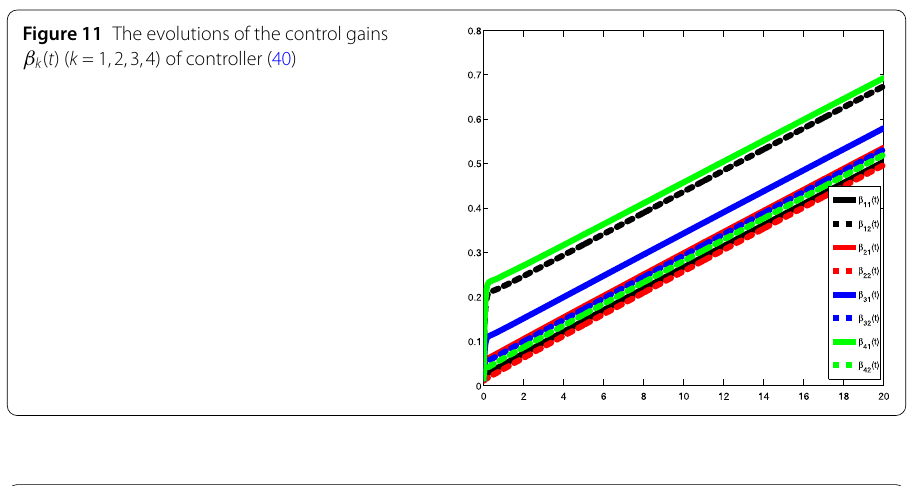
Figure 12 The evolutions of the control gains ξ k ( t ) ( k = 1,2,3,4) of controller